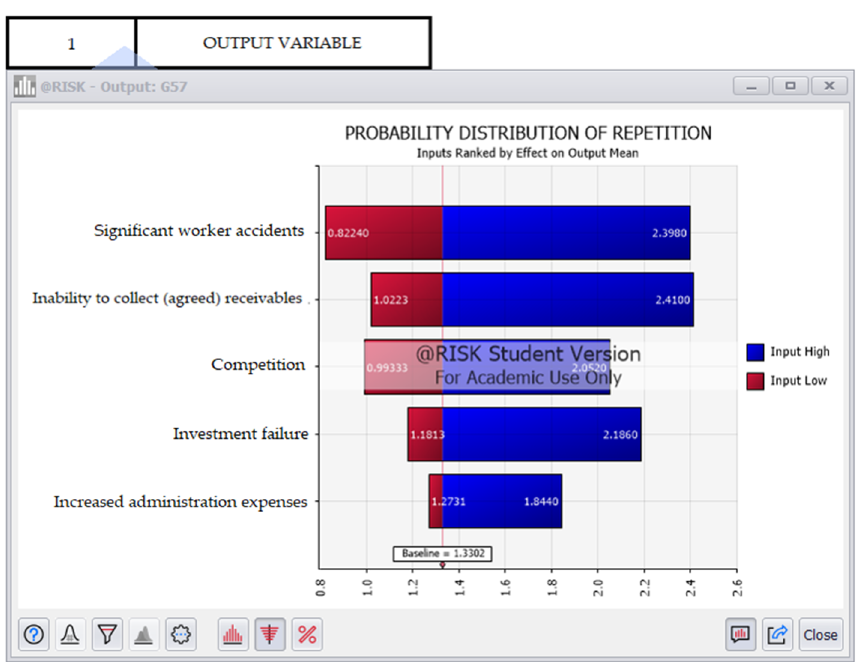
Figure 5. Risk—risk severity level.